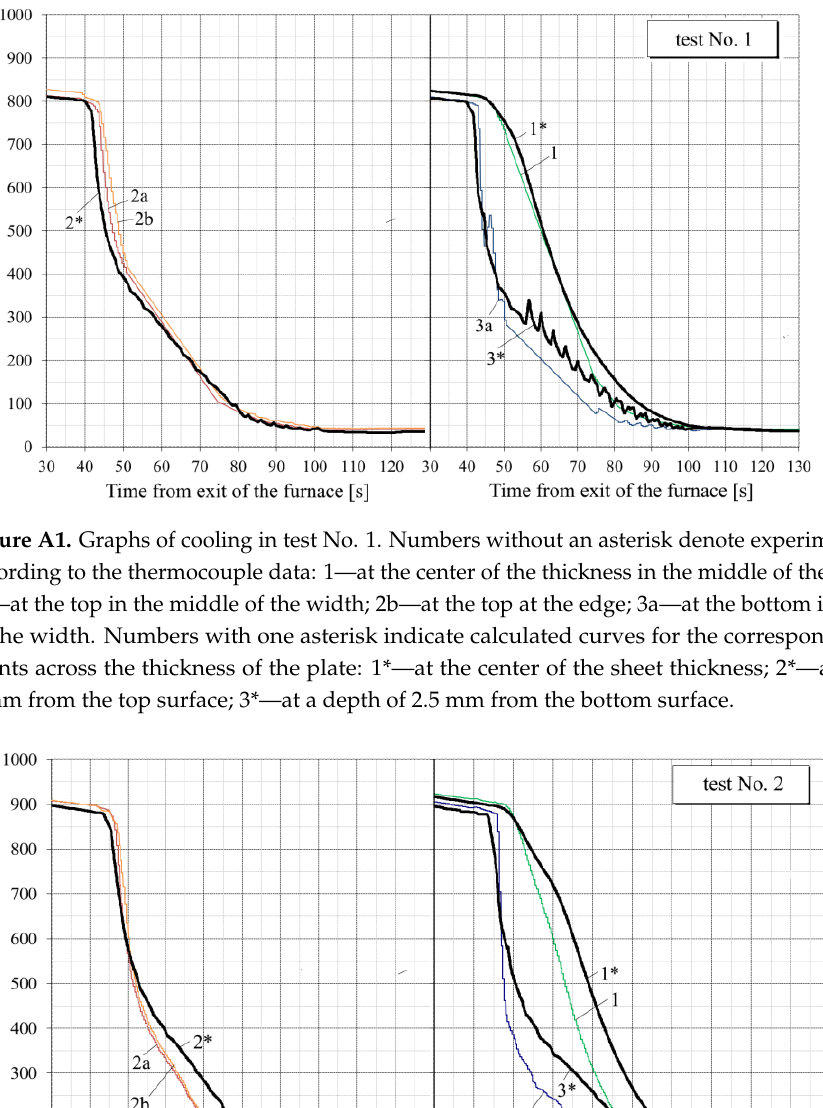
Figure A3. Graphs of cooling in test No. 4. The notations are the same as in Figure A1.